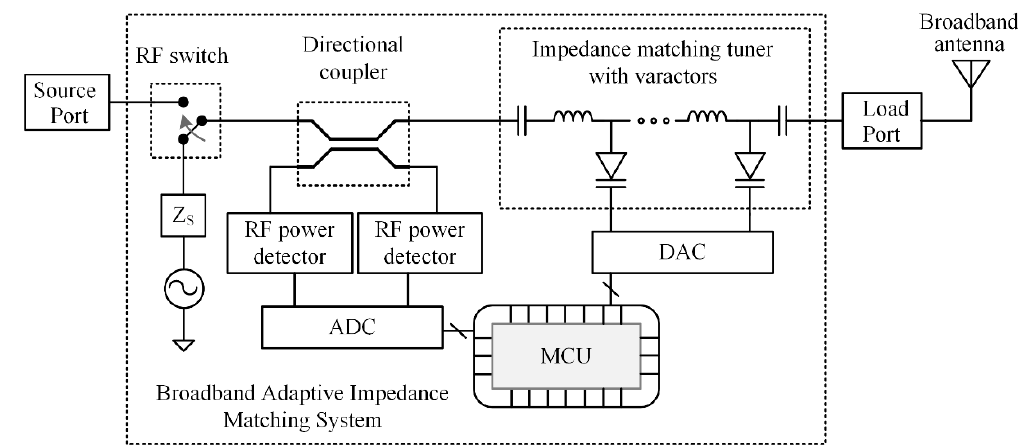
Figure 1. A generalized conceptual block diagram of the adaptive impedance matching system.